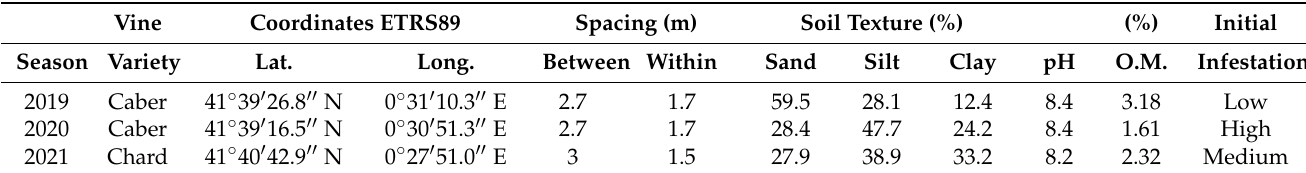
Table 1. Field characteristics by season. Vine variety, Caber: Cabernet Sauvignon, Chard: Chardonnay; Coordinates, Lat.: Latitude, Long.: Longitude; Vine spacing; Soil texture; pH, O.M.: Organic matter; Initial infestation level of Conyza bonariensis